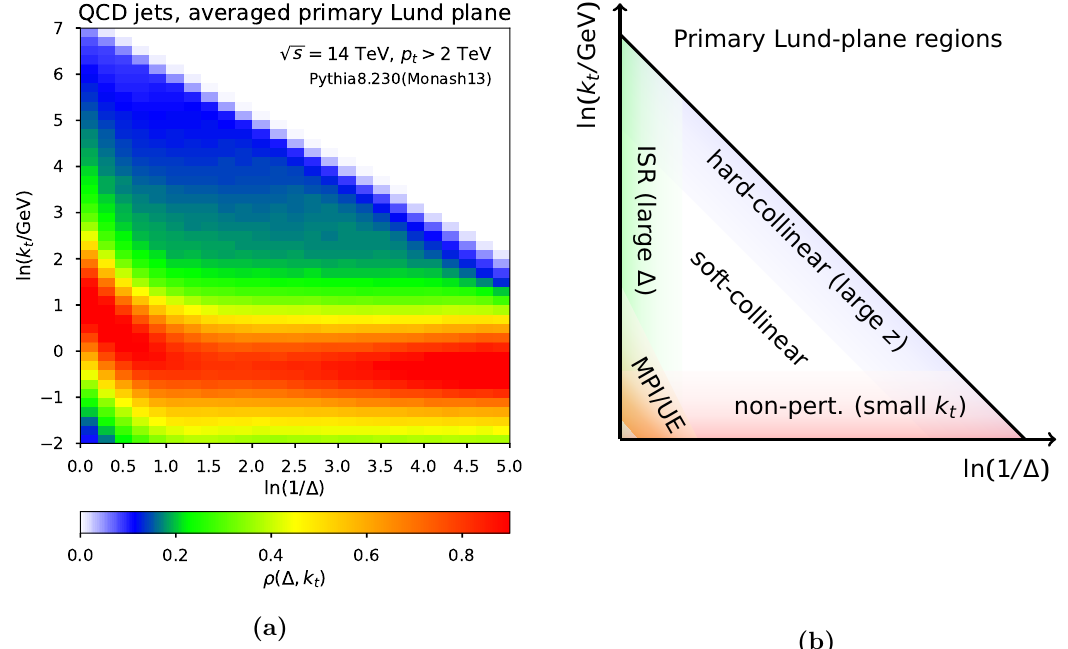
Figure 2. (a) The average primary Lund plane density, (cid:26) , for jets clustered with the C/A algorithm and R = 1 having p t > 2 TeV and j y j < 2 : 5, in a simulated QCD dijet sample. (b) Schematic representation of the di(cid:11)erent regions of the Lund